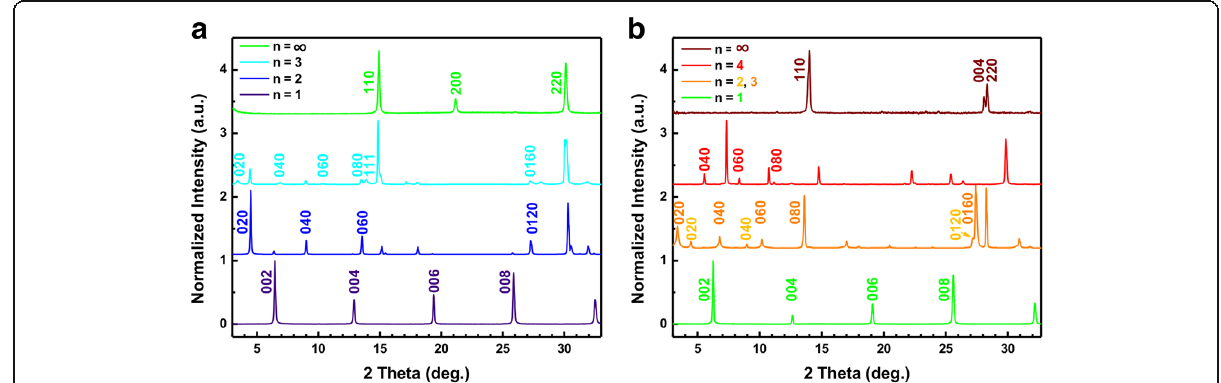
Fig. 4 XRD spectra of 2D RP perovskite QDs with a Br series and b I